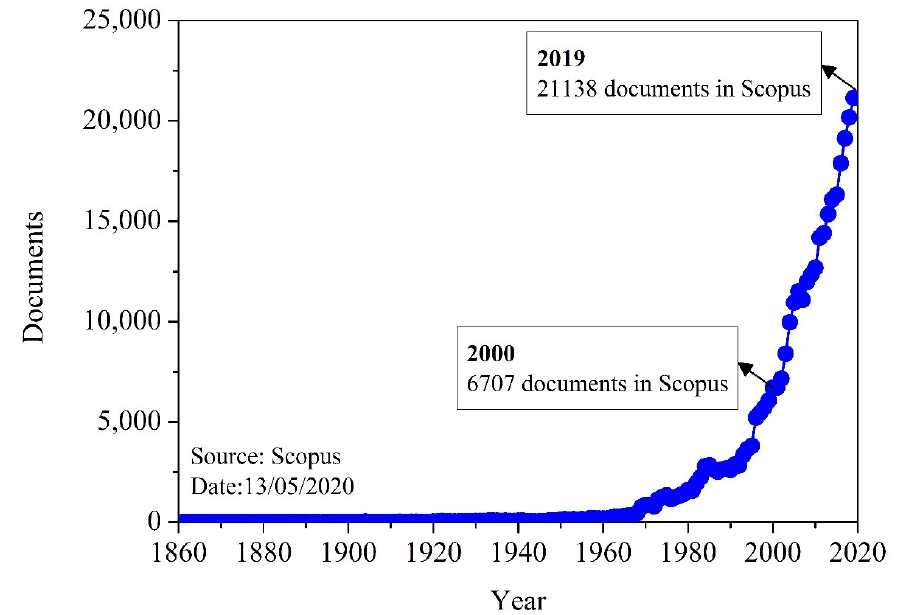
Figure 1. Number of published documents per year in the field of cellular materials (Source: Scopus).